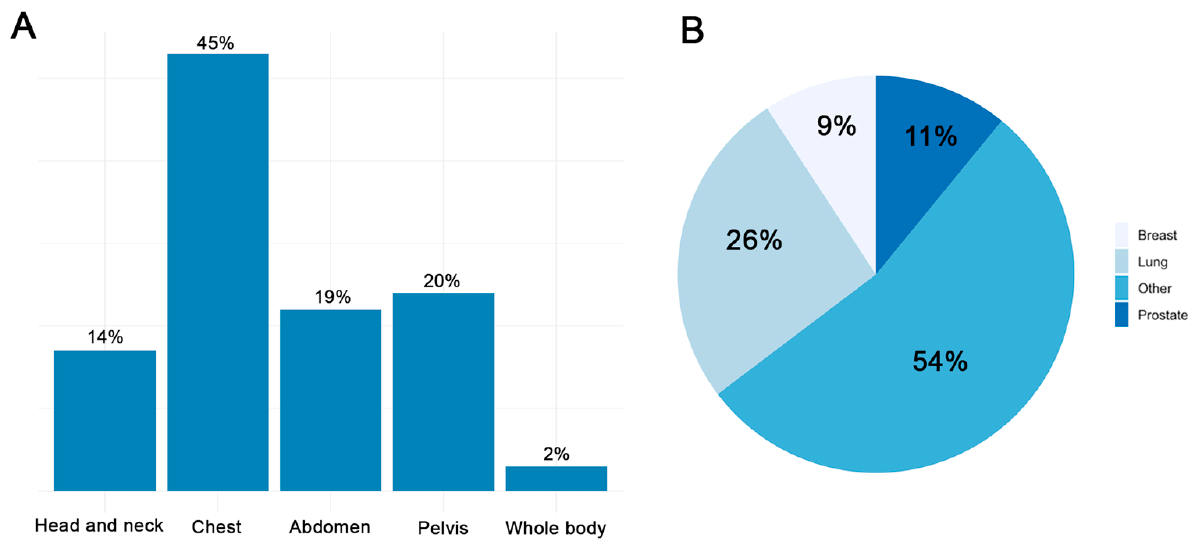
Figure 1. The proportion of body areas ( A ) and location of the tumor ( B ) treated with radiation therapy.